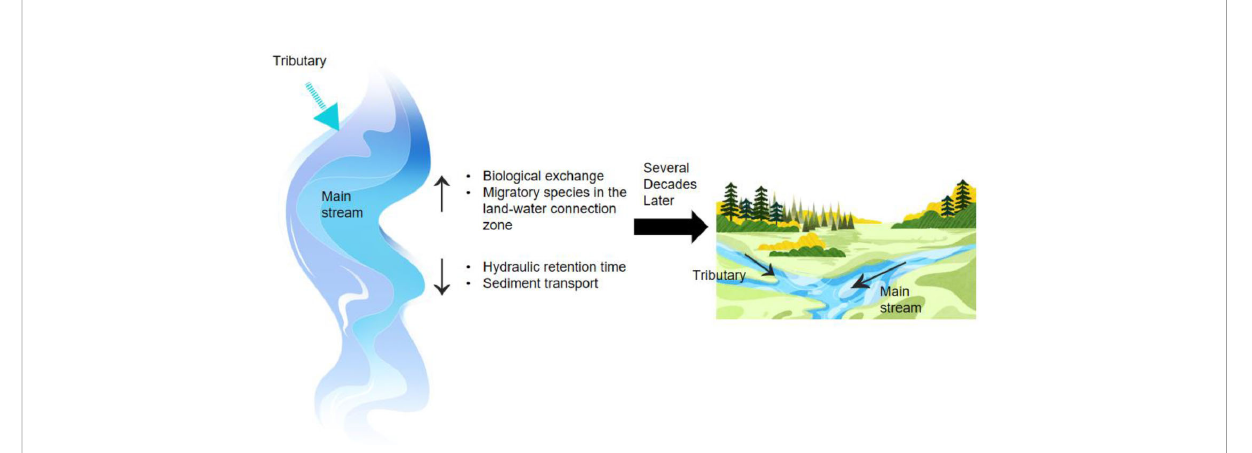
FIGURE 8 In fl uence of tributary habitat replacement on the ecosystem of the